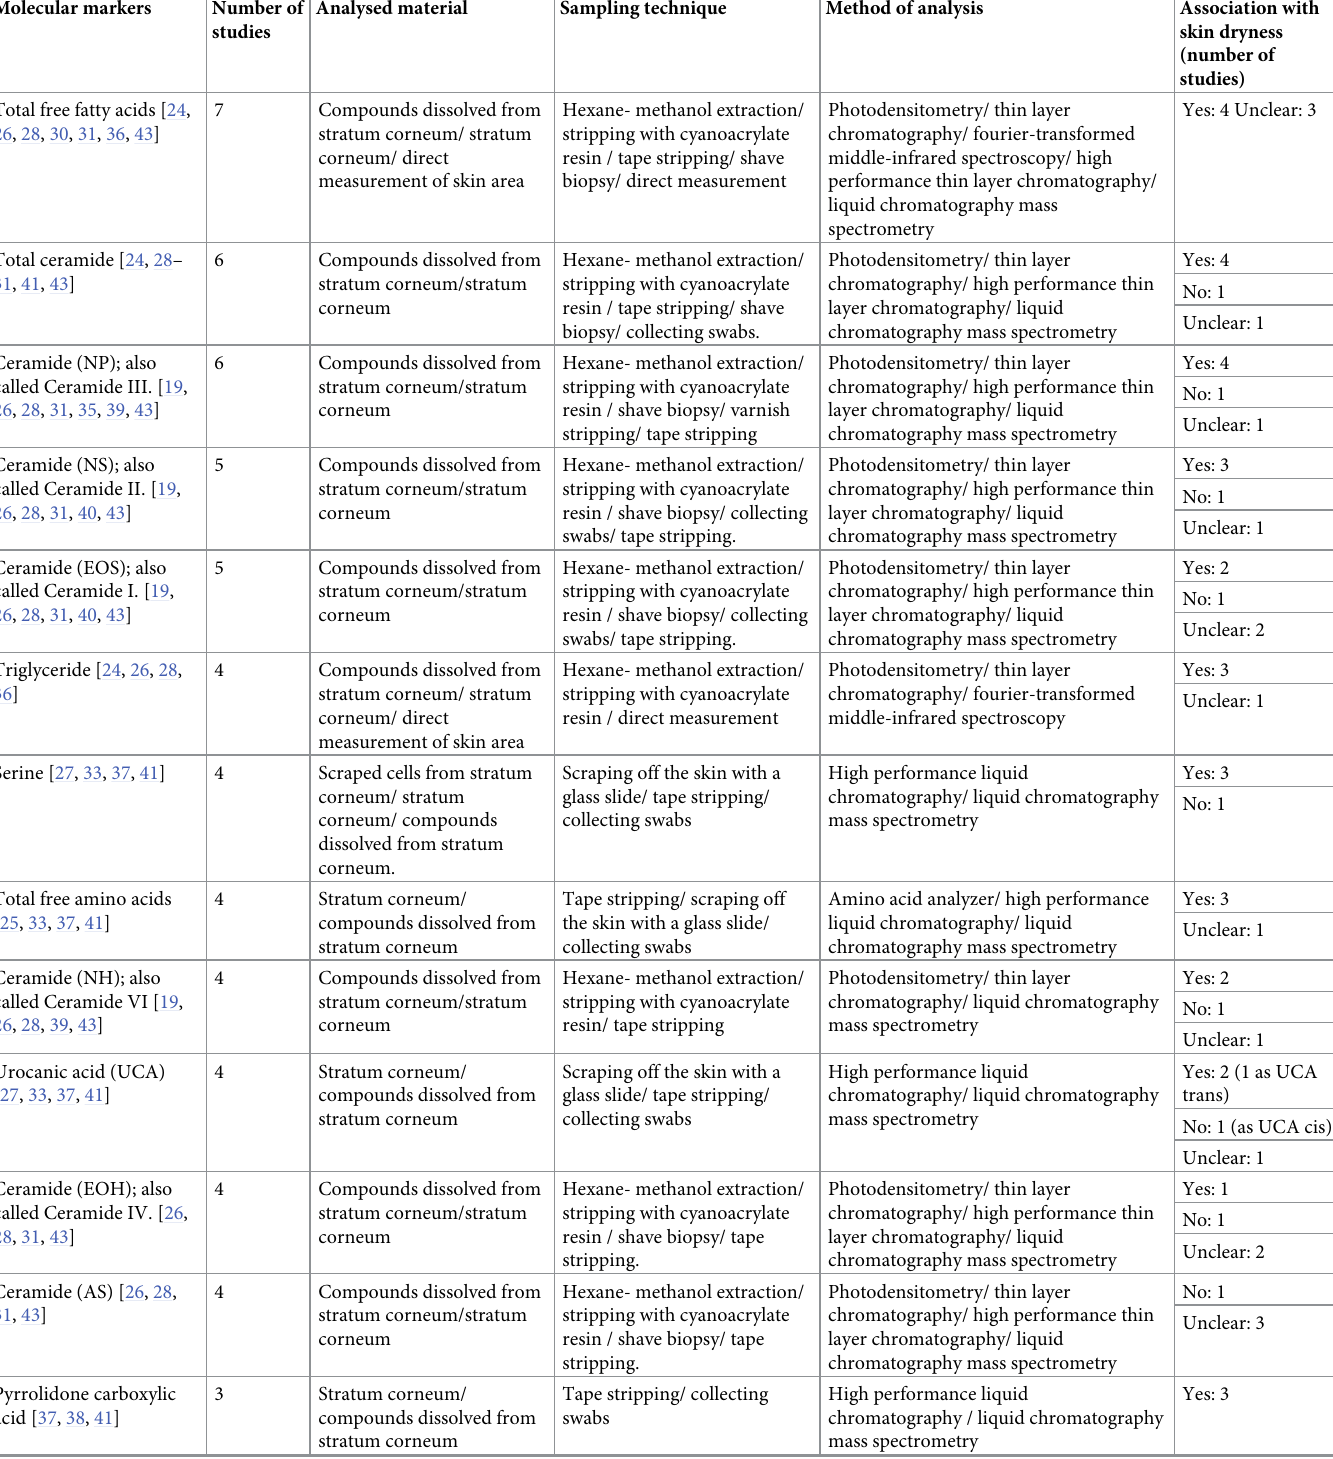
Table 2. Top markers (compounds analysed more than once). Molecular